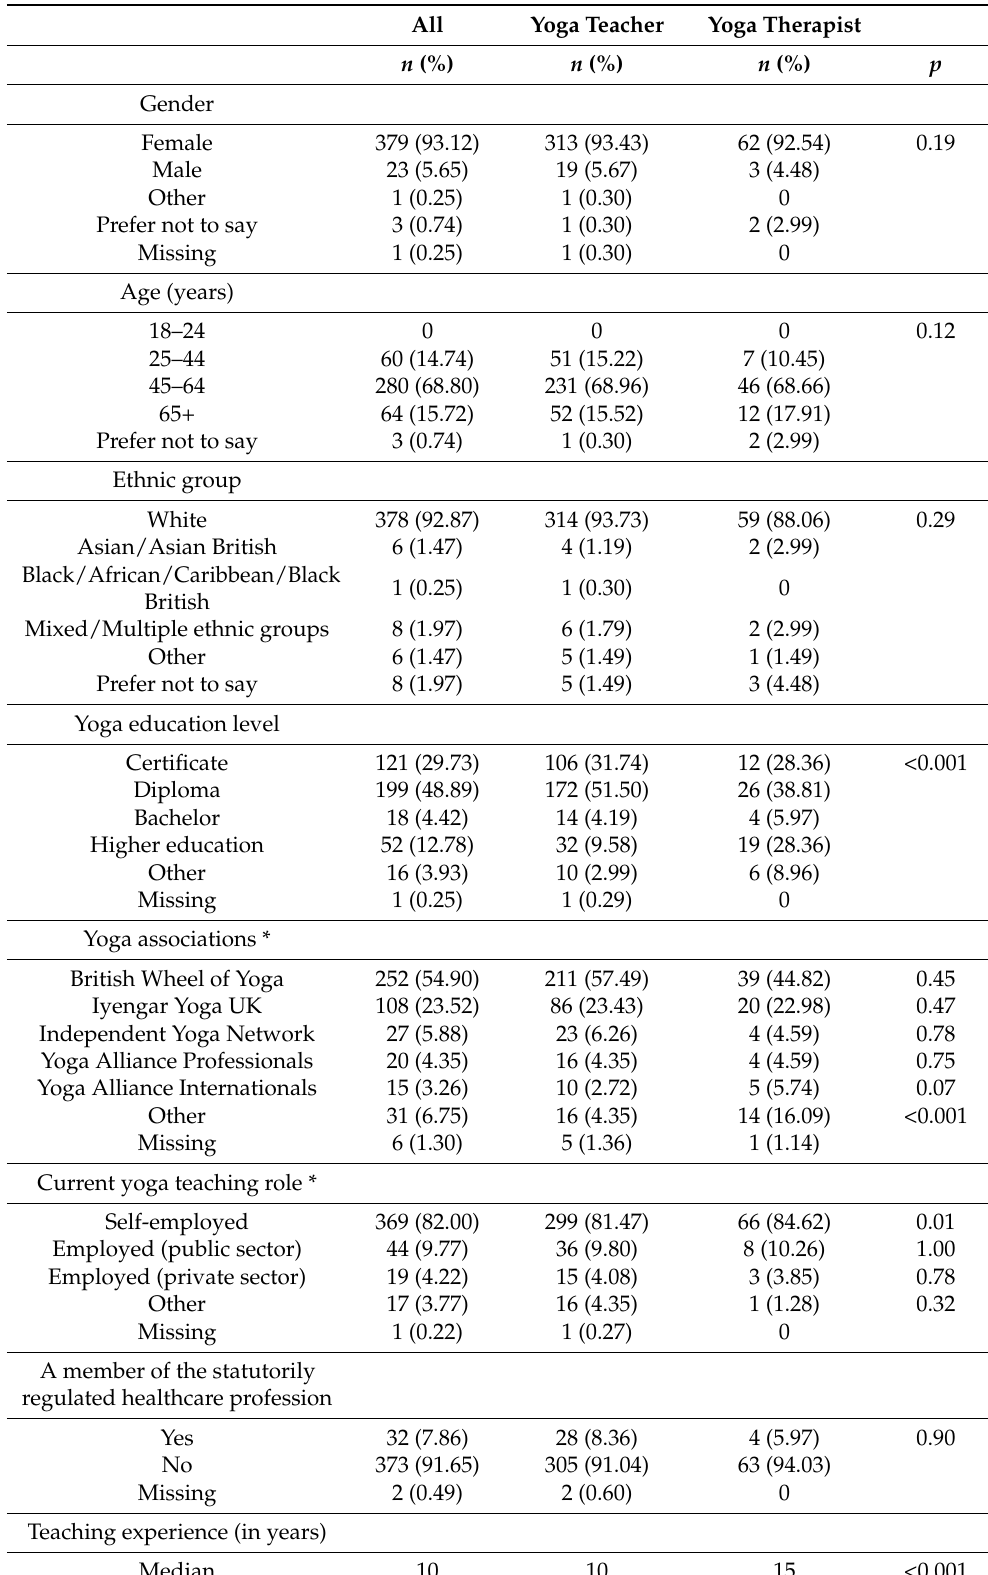
Table 1. Socio-demographic characteristics of the yoga